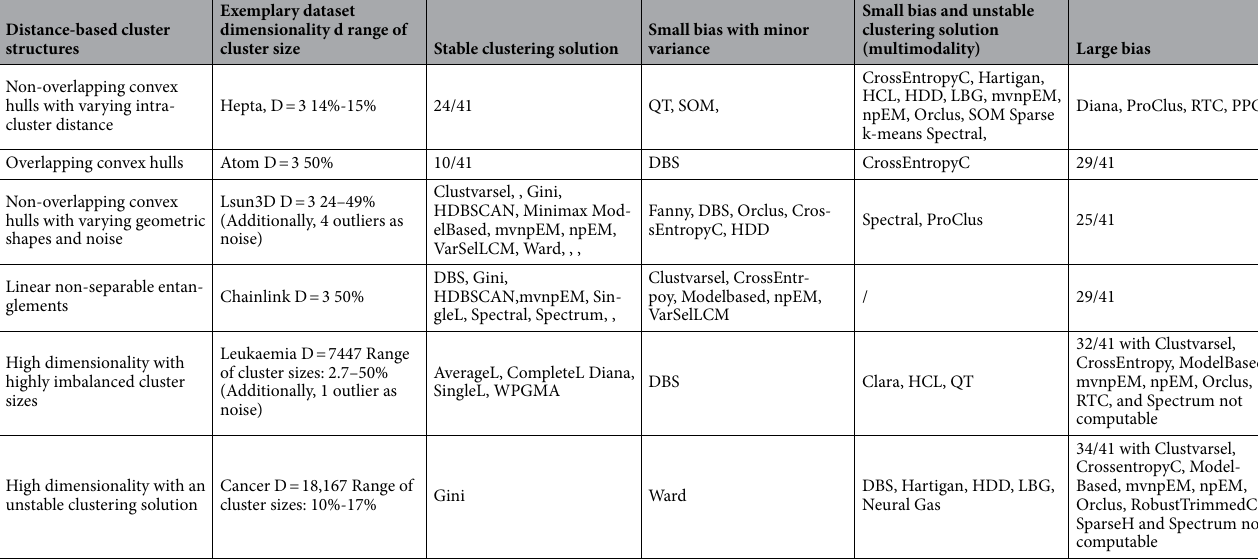
Table 1. Typical distance-based clustering challenges with one example dataset each. The table summarizes the results of SI C, Supplementary Fig. 10 and SI D Supplementary Figs. 11–14. No algorithm is able to reproduce all types of problems with highly stable results. The challenge that no distance-based cluster structures exist is not included in this table because benchmarking is not possible in this case. Note that the benchmarking performed here does not allow the deduction if an algorithm fails due to the cluster structures or due to the distribution of the